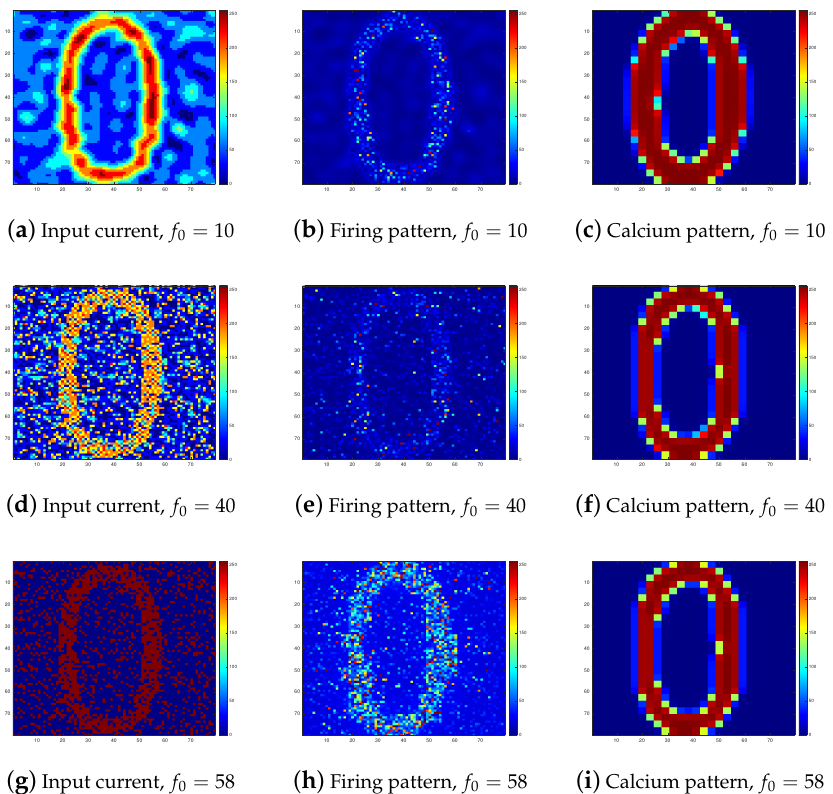
Figure 6. Snapshots for l = 4. The left panel displays the input current after being transformed by the low-pass filter at testing. The middle panel displays the firing pattern of neurons at t = 2.1 s. The right panel displays the calcium pattern of astrocytes at t = 2 s. In each sub-figure, the x- and y-axis denote the positional indices of the image. The colorbar describes the level of the input current, neuronal firing and astrocytic calcium concentration. The level has been scaled in the range 0–255 for visualization. The model exhibits very similar calcium patterns irrespective of the filter thresholds. From the first and the second column, we observe that f 0 = 10 smooths the picture and prevents over-firing of neurons; f 0 = 58 ensures that most of the digital pixels are firing; f 0 = 40 corrupts the picture to a certain degree. Therefore, the performance of f 0 = 40 is less